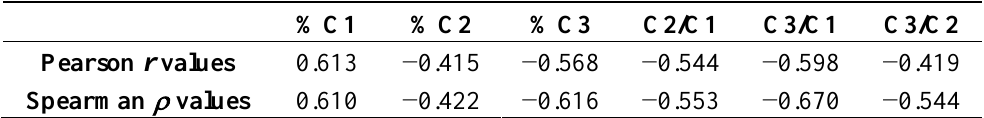
Table 4. Correlation coefficients (Pearson r values and Spearman  values) between biodegradability (BOD/COD) and chemical composition proxies based on EEM-PARAFAC (n =71, p <